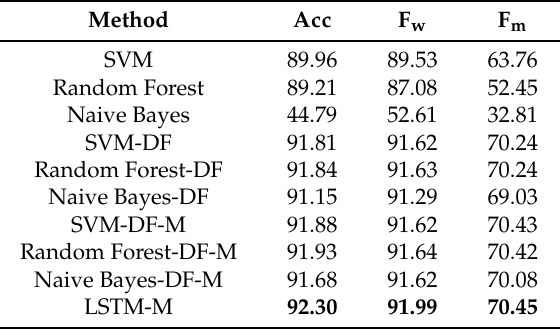
Table 3. Classification performance results (in percent) of three machine learning classifiers on the OPPORTUNITY dataset. ’-DF’ and ’-DF-M’ mean that the features used to train the three classifiers were obtained from the LSTM model and the LSTM-M model, respectively.